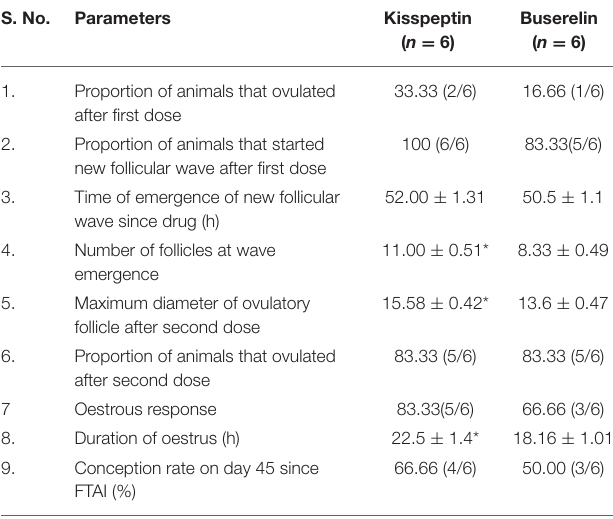
TABLE 3 | Follicular dynamics during oestrus synchronization: Effect of two different protocols involving kisspeptin or buserelin. S. No.